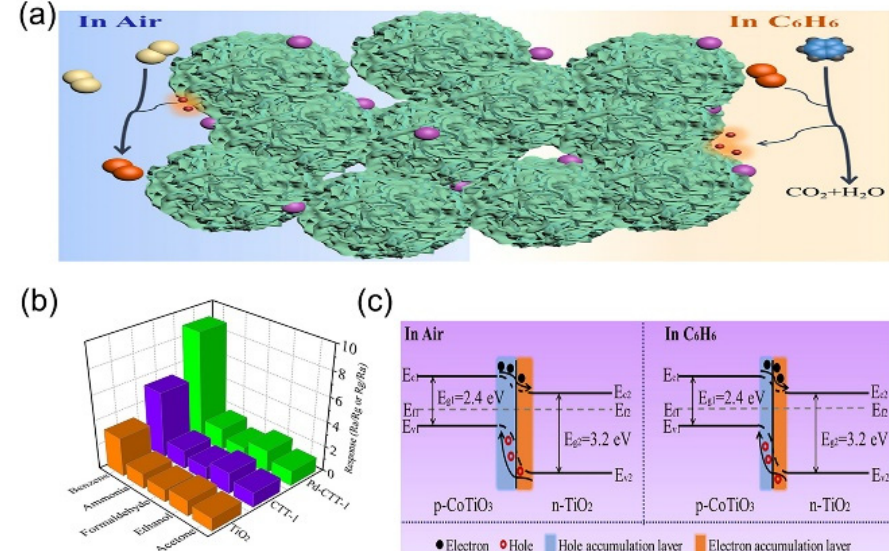
Figure 6. ( a ) Illustration of the sensor sensing mechanism. ( b ) Selectivity of PD-CTT-1 sensor for various test gases up to 10 ppm. ( c ) The energy band structure of CoTiO 3 and TiO 2 . Reproduced with permission from Ref. [42]; published by Elsevier, 2022.